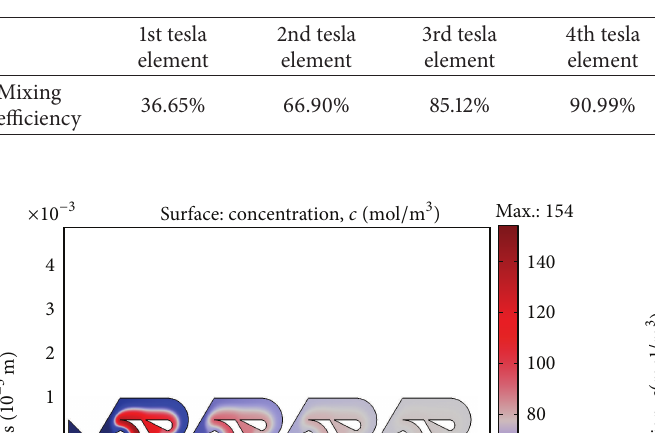
Table 2: Mixing efficiency coefficients computed at the cross sections of the outlet channels of every tesla element of the passive micromixer.